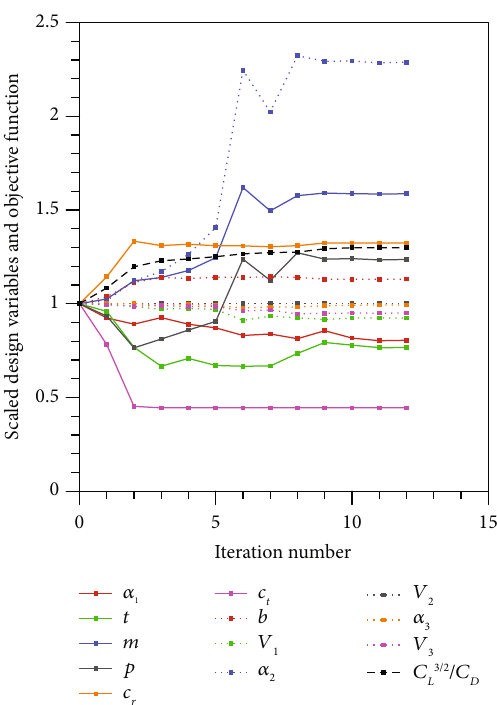
Figure 17: The variation of the objective function and the design variables in Case